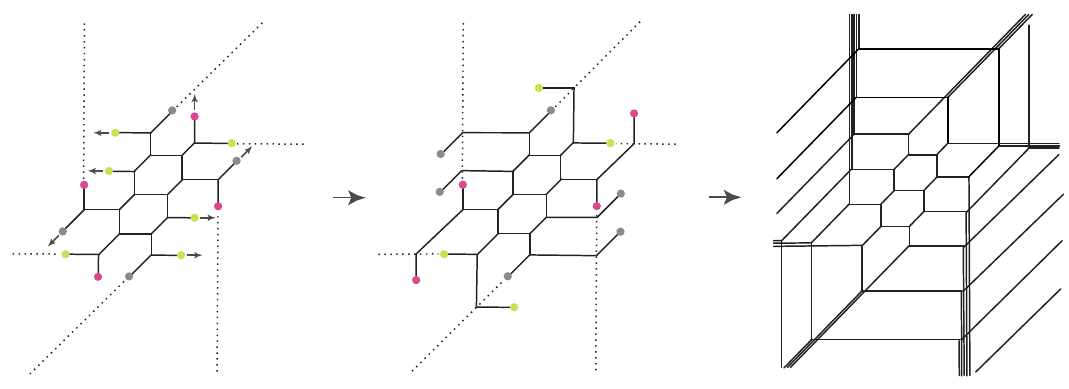
Figure 3 . Tao diagram for 5d = 1 SU(3) gauge theory with N f = 10 (cid:13)avors which is a circle N compacti(cid:12)cation of 6d = (1 ; 0) Sp(1) gauge theory with one tensor multiplet and 10 (cid:13)avors. The N rightmost brane con(cid:12)guration on (cid:12)gure 2 can be reorganized to be the leftmost web con(cid:12)guration given here, using 7-brane monodromies. Pulling out 7-branes passing through the branch cut of other 7-branes gives a Tao wed diagram on the